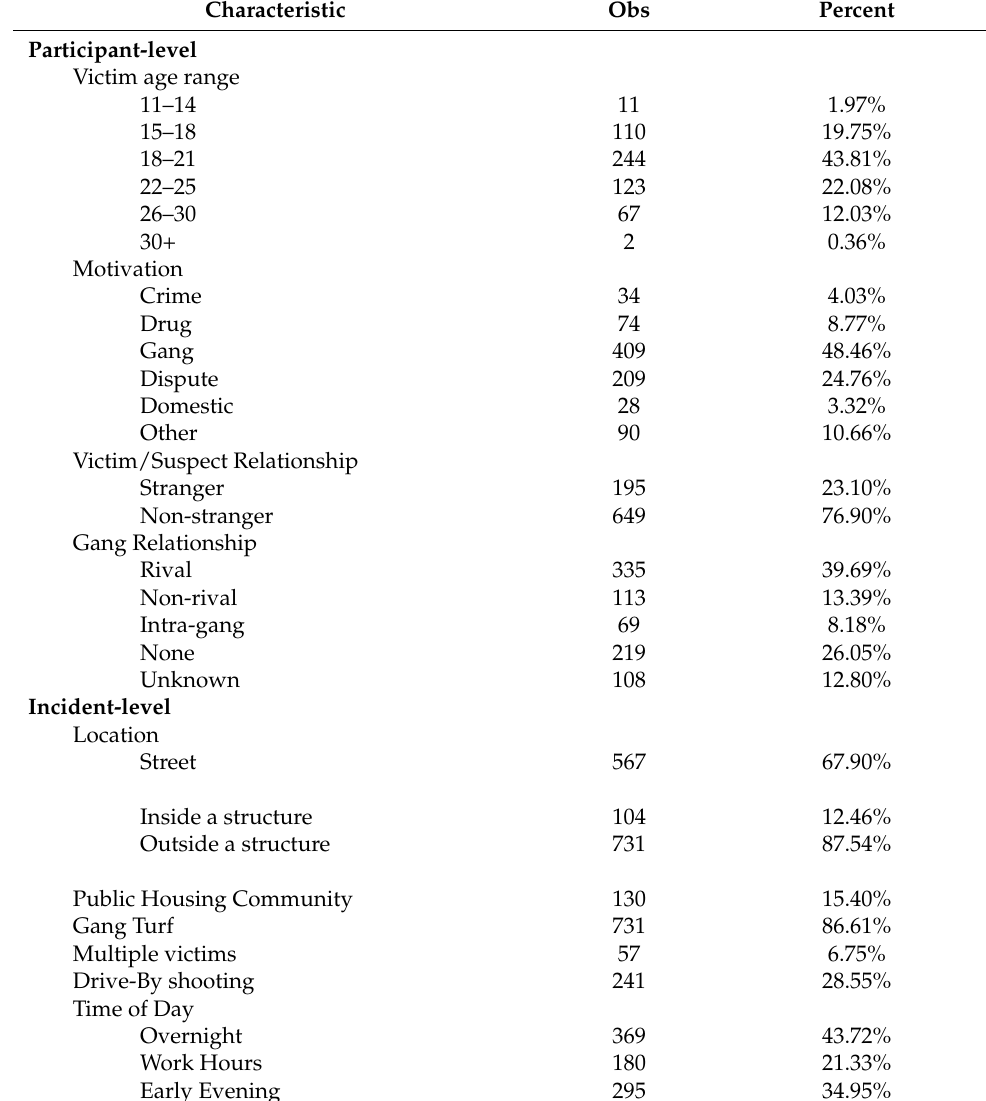
Table 1. Descriptive statistics for gang-related homicides, 1978–2012 ( N =